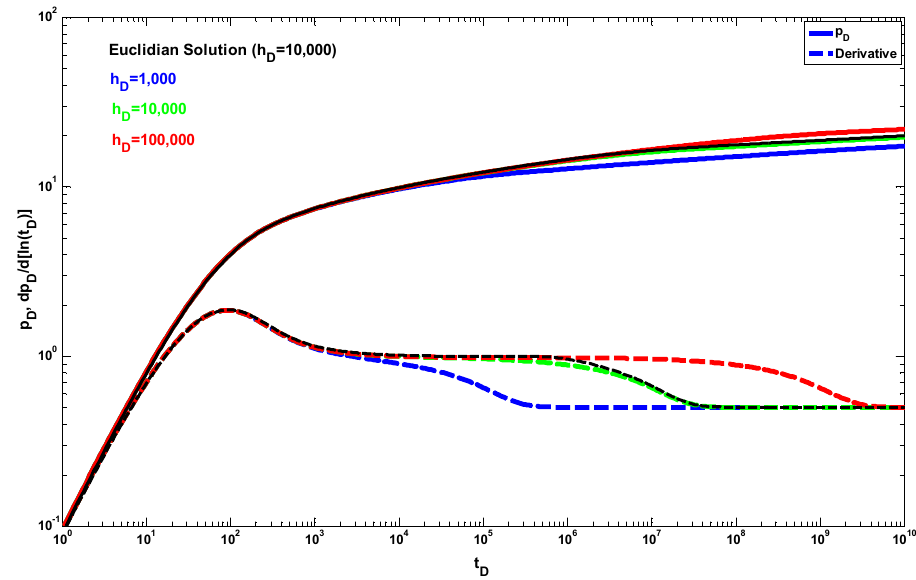
Figure 2. Euclidean case: z wD = 0, h pD = 0.5, S = 0, C D = 10, ε = 1, d fr = 2, θ r = 0, d fz = 1, θ z = 0.